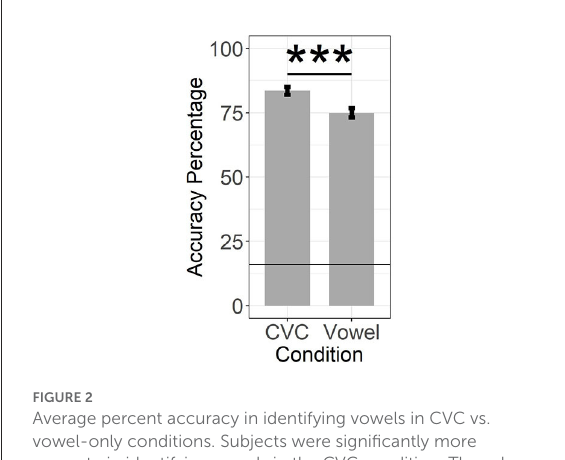
FIGURE2 Average percent accuracy in identifying vowels in CVC vs. vowel-only conditions. Subjects were significantly more accurate in identifying vowels in the CVC condition. The value of chance was 0.16 (represented by the black horizontal line). Error bars represent standard error, p < 0.0001, Wilcoxon signed-rank test. *** p < 0.0001.